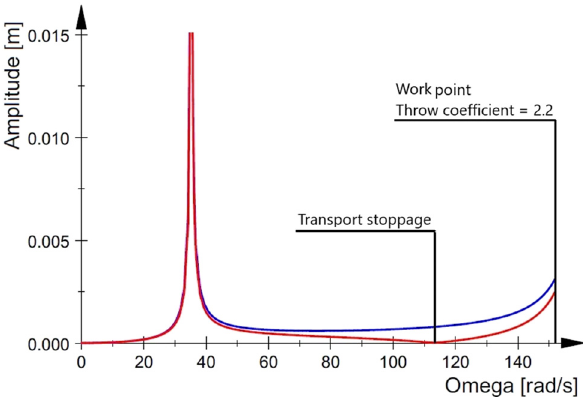
Figure 4: Amplitudes of the trough ( red line ) and the eliminator ( blue line ) as a function of the excitation frequency, for the strategy of operating behind the